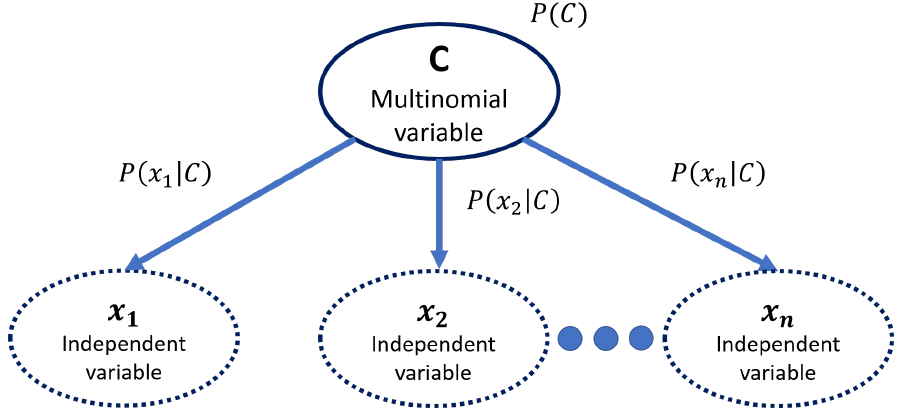
Figure 8. Example of the probability tree of the Bayes algorithm.